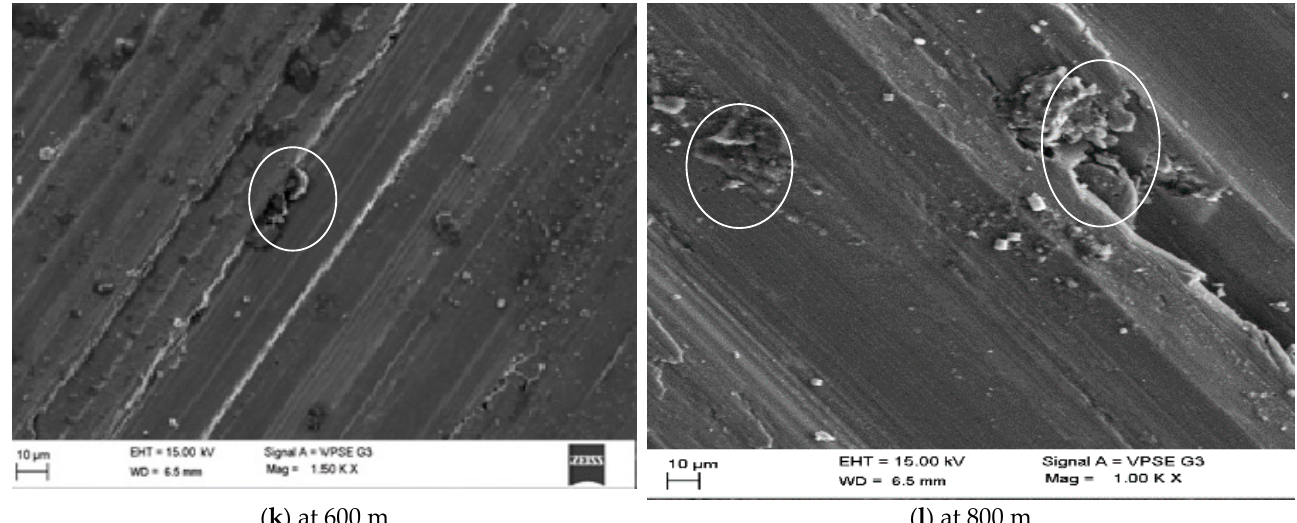
Figure 8. Worn surface of the samples with respect to sliding distance: ( a – c ) S, ( d – f ) S1, ( g – i ) S2, and ( j – l ) S3.